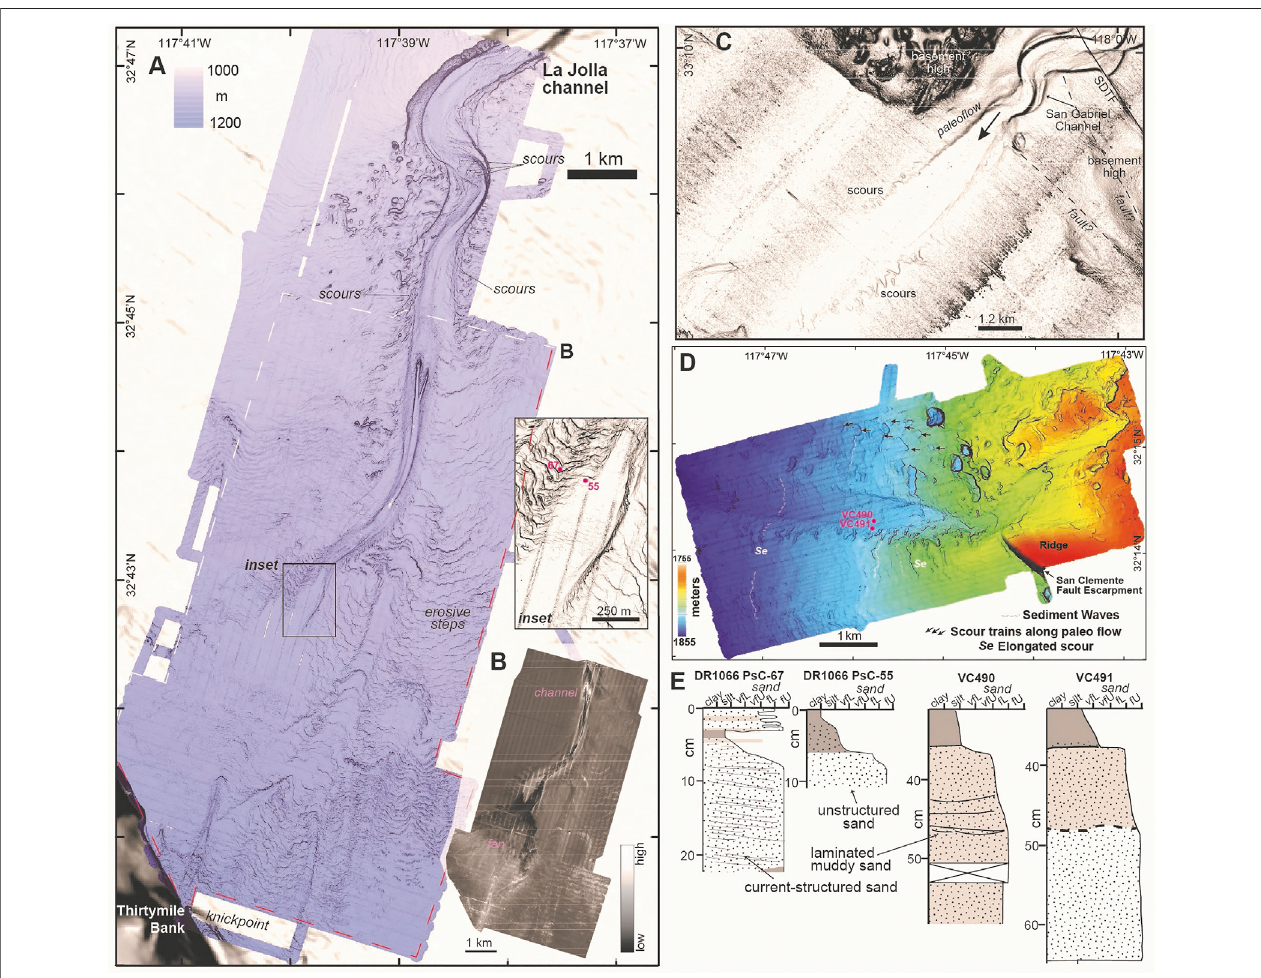
FIGURE 4| Channel mouth expansion zone (CMEZ) examples from offshore Southern California. La Jolla Fan high-resolution (1-m grid) multibeam bathymetry (A) and backscatter (B) (modi fi ed from Maier et al., 2020). Regional bathymetry from Dartnell et al. (2015). (C) San Gabriel channel and fan, Catalina Basin (modi fi ed from Maier et al., 2018). (D) Navy Fan (modi fi ed from Carvajal et al., 2017). (E) Sediment cores from the Navy Fan (right; modi fi ed from Carvajal et al., 2017) and La Jolla Fan (left; from Maier et al., 2020); see inset and part (D) , respectively for core locations.